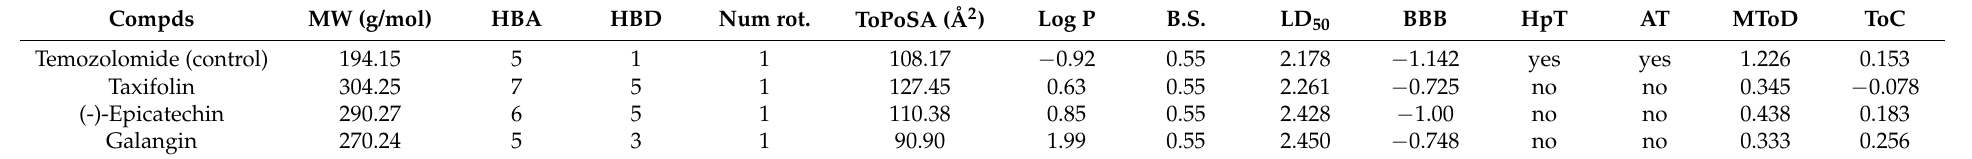
Table 2. ADMET properties of flavonoid